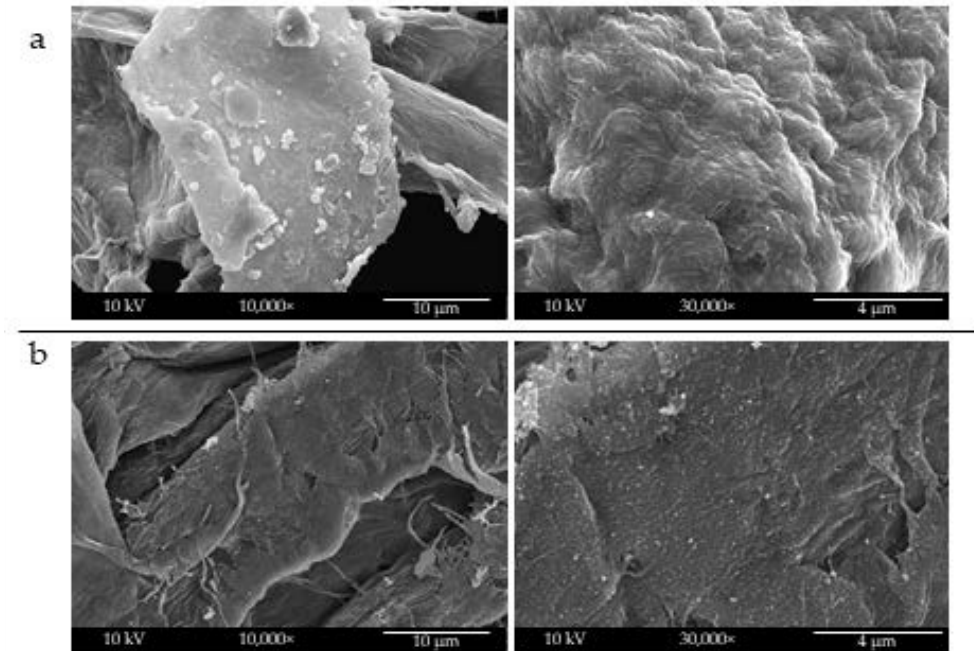
Figure 3. SEM analysis of cellulose tissue decorated with electrosprayed mCNs using different solvent systems: ( a ) distilled water and ( b ) distilled water/acetic acid (50/50 w / w ). Left column shows zoomed-out (10,000 × ), while right column shows zoomed-in (30,000 × )